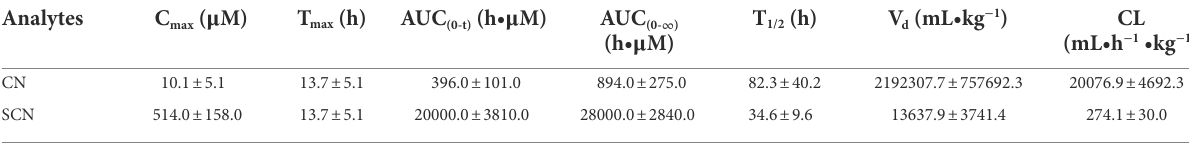
TABLE 3 Pharmacokinetics parameters of CN and SCN after oral administration of amygdalin for PGF group (mean ± SD, n = 6).